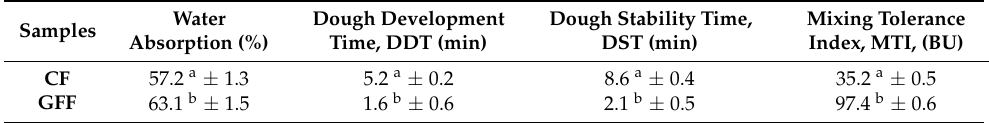
Table 2. Farinographic characterization of control flour (CF) and Gluten Friendly™ flour (GFF) 1 .